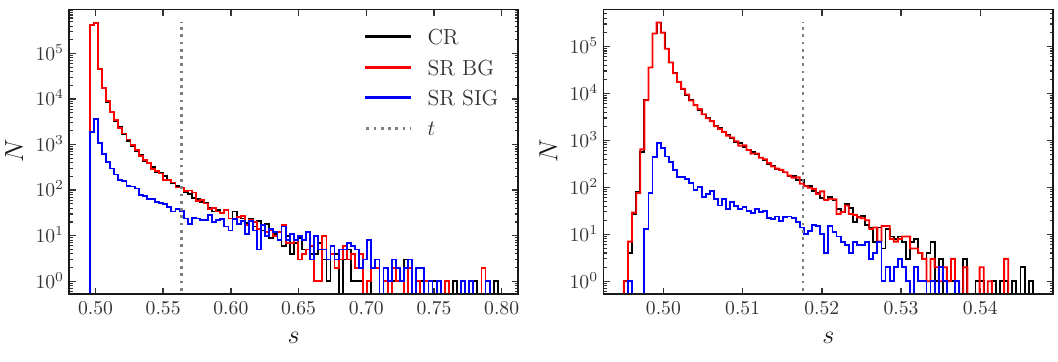
Figure 1 . The absolute number of events in the signal region (Z+jet events in red, semivisible jets in blue) and the control region (only Z+jet events in black) is shown as a function of the classifier score s ∈ [0 , 1] for f SR = 1% (left) and f SR = 0 . 5% (right). Note the different scale on the x -axis in the two plots. We also show the threshold value t for (cid:15) CR = 0 . 001 as a vertical line.